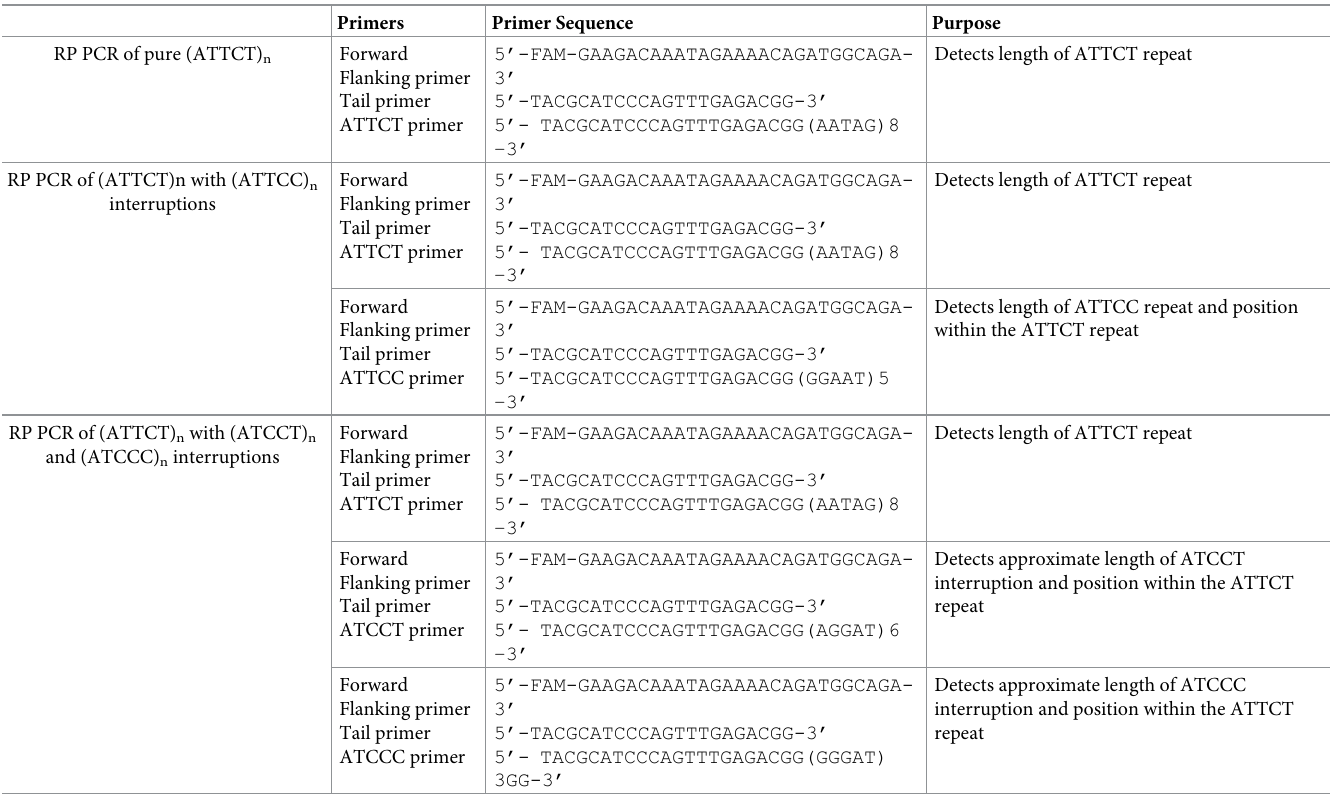
Table 1. Primers used in RP PCR to detect the various repeat